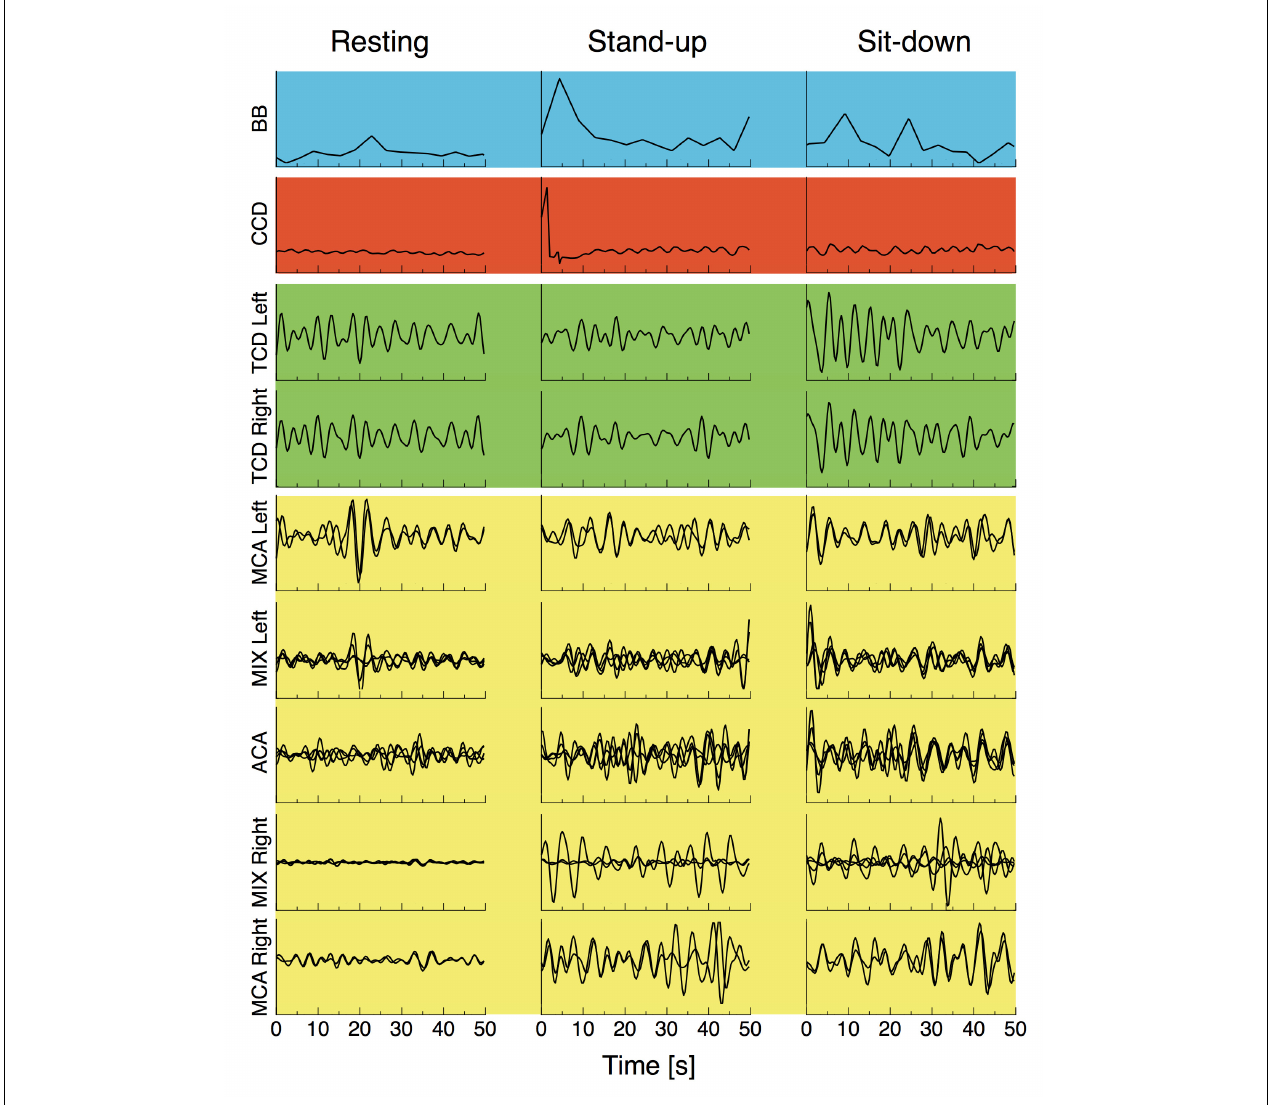
FIGURE 3 | Breath-to-breath interval (BB), cardiac cycle durations, preprocessed blood flow velocity signals acquired from the middle cerebral artery (TCD Left and TCD Right) and preprocessed NIRS signals from different vascular territories are displayed for a representative subject in the resting state, and right after standing up and sitting down. All signals were resampled at 3 Hz and bandpass filtered in the 0.4–1.5 Hz range, blood pressure fluctuations were regressed from all cerebral hemodynamic (i.e., macro- and microcirculatory) signals as described in “Materials and Methods” section. Background colors of the signal panels are the same used in Figure 2